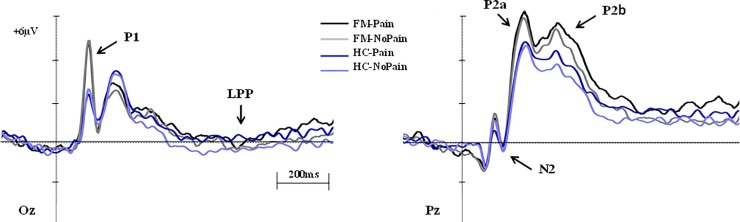
Grand averages corresponding to fibromyalgia (FM) and healthy control (HC) participants in response to Pain and No pain conditions.Scales and polarity are shown at central and posterior areas.